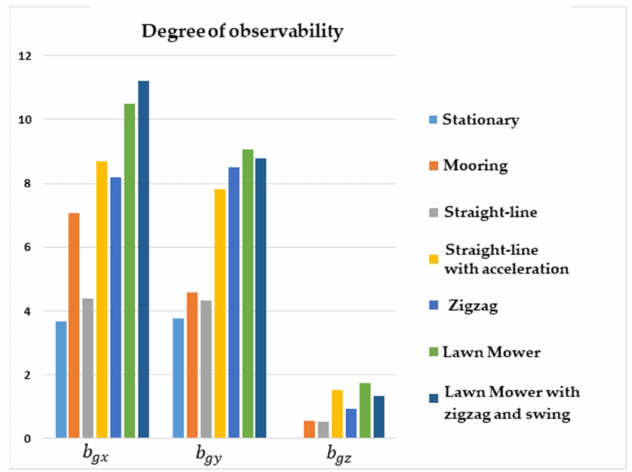
Figure 2. Degrees of observability of the gyro biases. INS/GPS/DVL/PS integration.